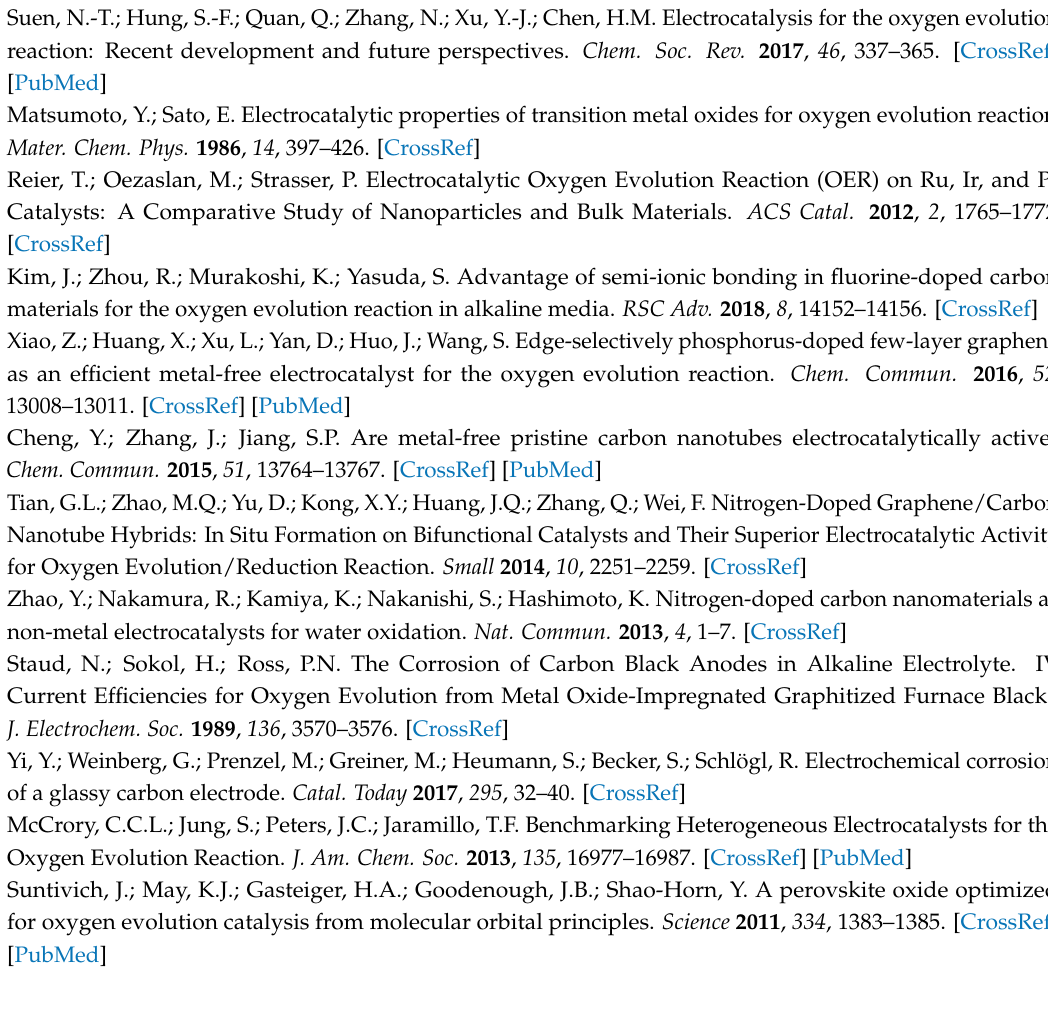
Figure S1: XPS results of F–carbon around (a) F 1s range and (b) wide scan; Figure S2: Electrochemical cell setup. Three-electrode cell was used for the controlling the electrochemical potential of working electrode. Evolved O 2 was detected by O 2 sensor immersed in solution; Figure S3: OER from RuO 2 in 0.1 M KOH solution (pH = 13). (a) Applied potential (E), (b) current density (j), and (b) O 2 concentration ( C O ) were plotted versus time; 2 Figure S4: Chronoamperometry at different electrochemical potentials. Applied electrochemical potentials were shown in above; Figure S5: Time–course analysis of O 2 concentration trace under the potentiostatic polarization. Applied electrochemical potentials were shown in above; Figure S6: Correlation between rate of OER and current density in RuO 2 under oxygen evolution condition. Data was adapted from Figure S3; Table S1: Calculation of Faradaic efficiency for F–carbon under OER conditions in pH 13; Table S2: Calculation of Faradaic efficiency for F–carbon under OER condition in pH 13.5; Table S3: Calculation of Faradaic efficiency for F–carbon under OER condition in pH 14; Figure S7: Mulliken charge analysis for semi-ionic C–F model structure and covalent C–F model structure. Green color and red color indicates the positive and negative charges respectively; Appendix: Cartesian coordinates for C 42 H 16 and C 42 H 16 F (semi-ionic and